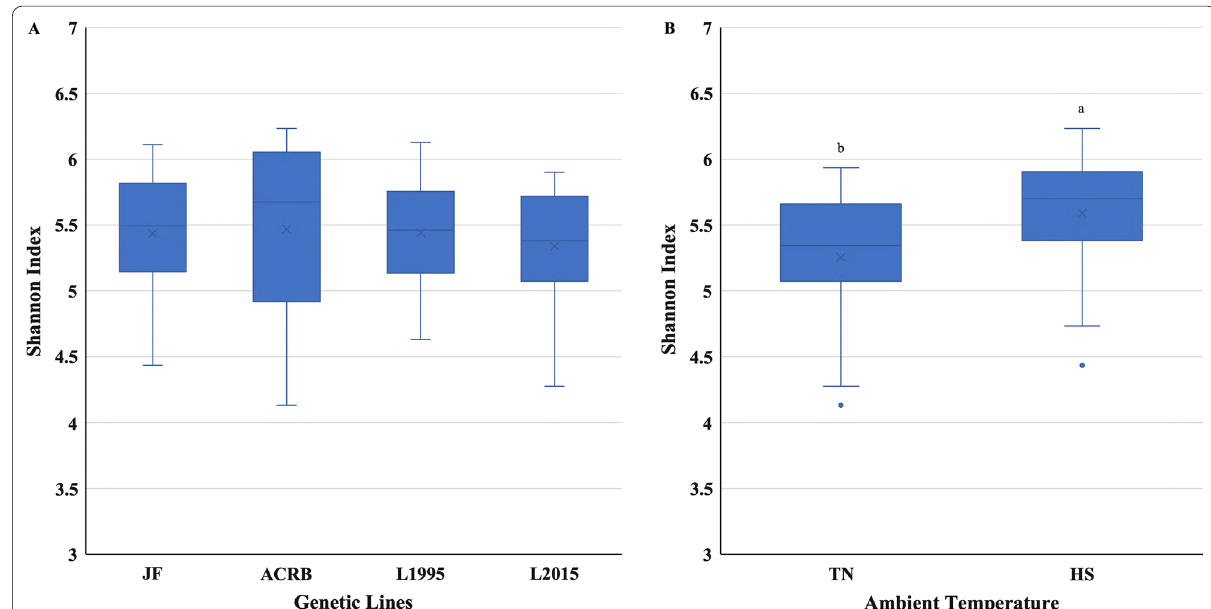
Fig. 1 Alpha diversity in the ileal content of Jungle Fowl (JF), Athens Canadian Random Bred (ACRB), 1995 Random Bred (L1995), and 2015 Modern Random Bred (L2015) chicken lines raised under thermoneutral (TN) or heat stress (HS) condition (8 h/d; 36 °C) on d 56. A Shanon’s diversity index for genetic lines. B Shanon’s diversity index for ambient temperature. Boxplots show the quartiles, median, and extremities of the values